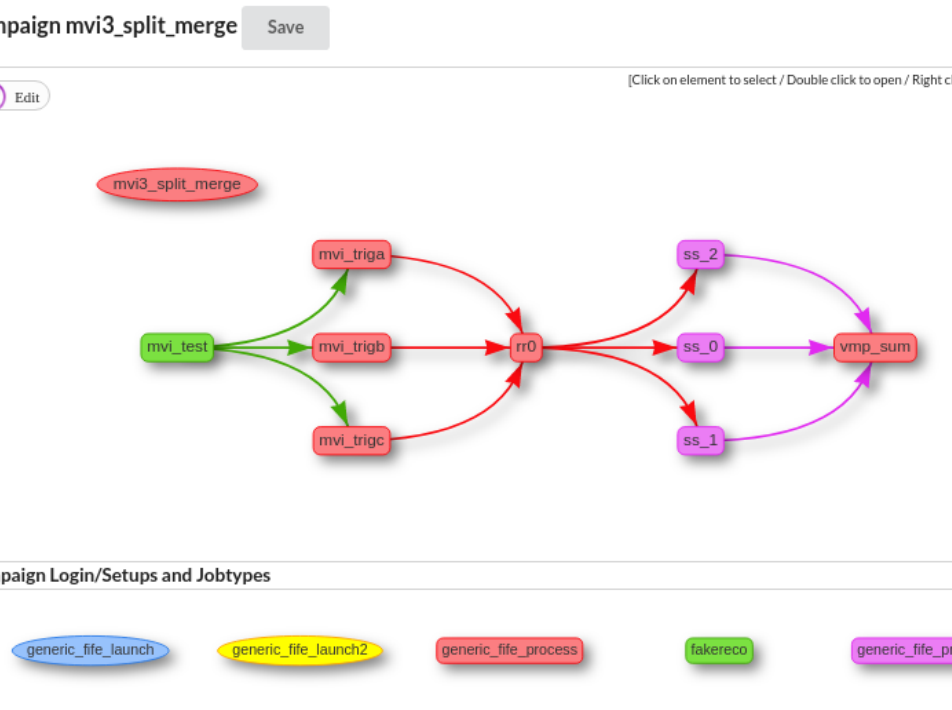
Figure 3. POMS Example of a campaign, shown in the GUI editor, with stages connected by their